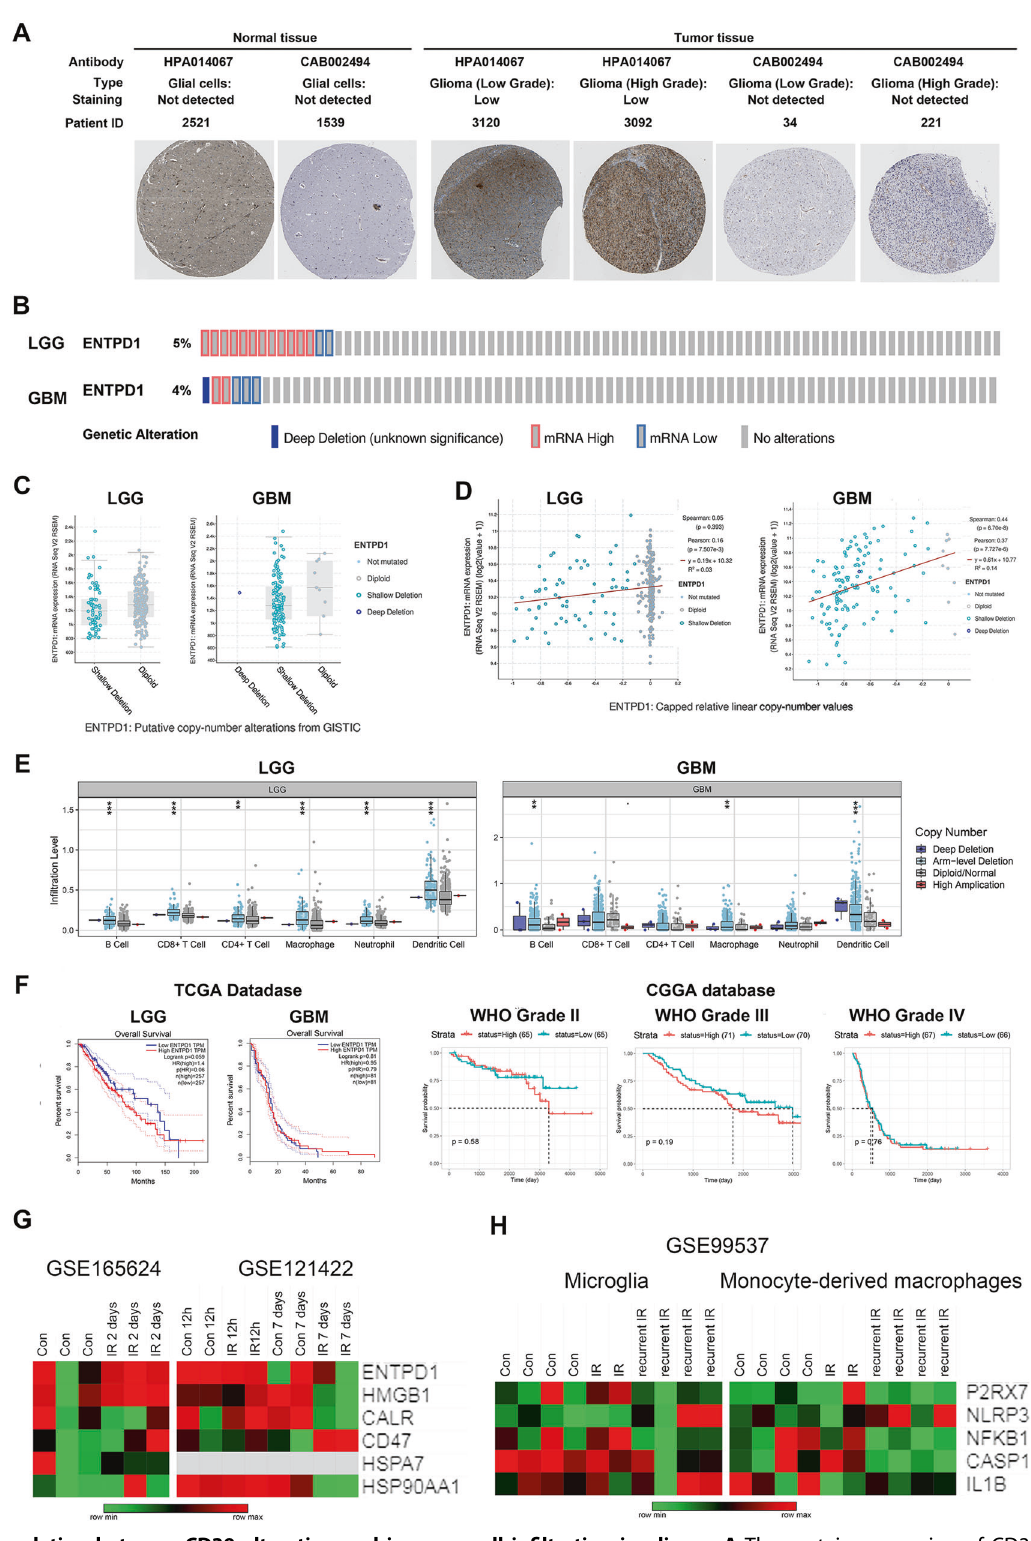
Fig. 5 The correlation between CD39 alteration and immune cell in fi ltration in glioma. A The protein expression of CD39 using IHC in glioma patients from HPA database. B The changes in genome and mRNA of CD39 in TCGA dataset were showed. C The copy number alterations of CD39 gene were showed. D The relative analysis of CD39 copy number and mRNA expression value were showed. E Box plots showed the distributions of immune subset at each copy number status of CD39 gene. F Kaplan – Meier plots showed the differences between CD39 high and CD39 low patients ’ survival from TCGA and CGGA databases. G Heatmap of mRNA-Seq analysis of ICD hallmarks expressions in different periods after radiation in GBM cell lines. H The indicated gene expression values in immune cell subtypes were depicted after